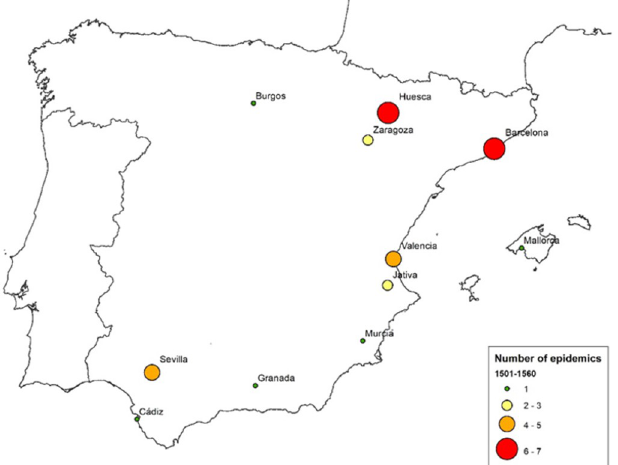
Fig 2. Spanish cities most affected by epidemics during the 16 th century (1501–1560). Source: Villalba [48] and own elaboration. Base map from the Centro Nacional de Informacio´n Geogra´fica